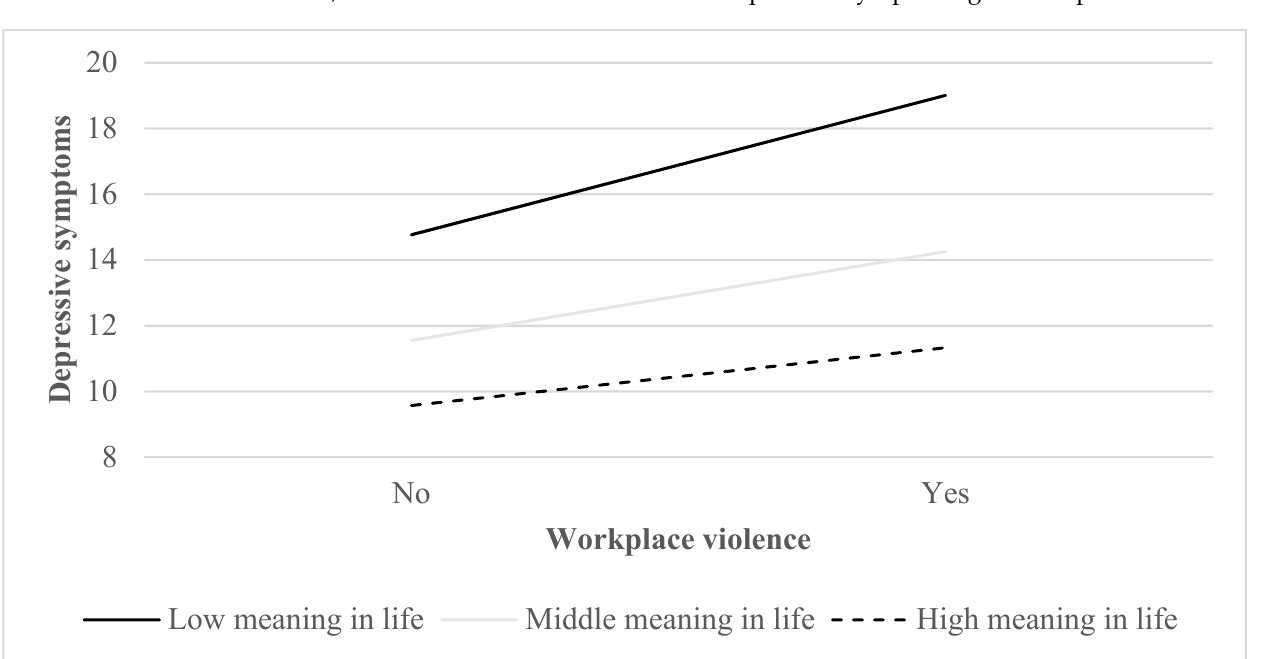
Figure 1. Meaning in life moderated the relationship between workplace violence and depressive symptoms among primary health care professionals.